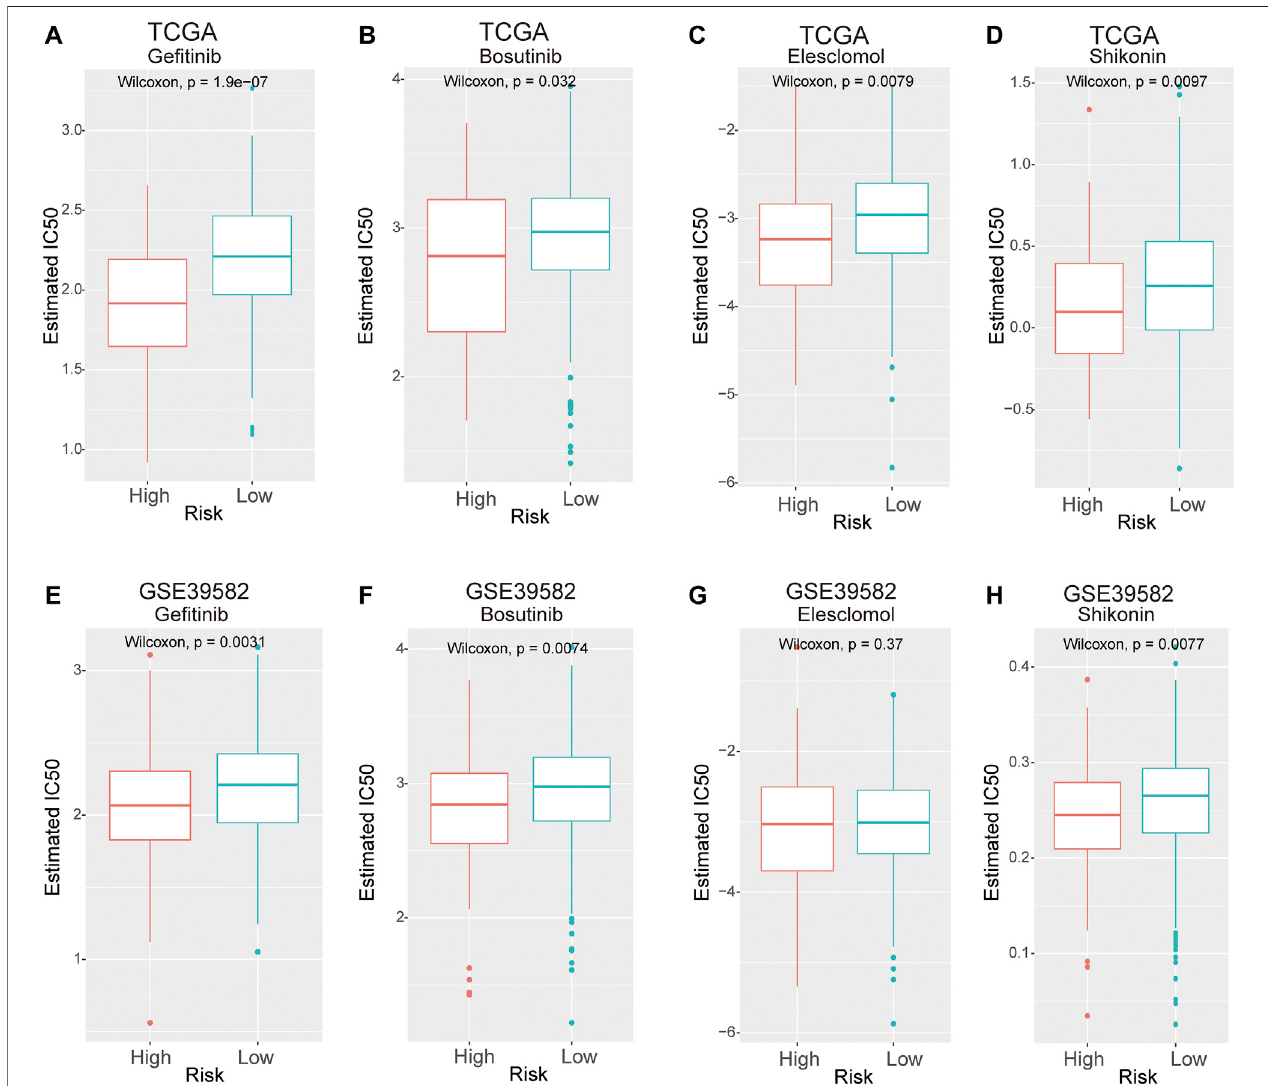
FIGURE8| TheIC50valuesoffourchemotherapeuticagentswithan8-lncRNAsignatureintheTCGAandGEOcohorts. (A – D) Ge fi tinib,camptothecin,bosutinib, and shikonin in the TCGA cohort. (E – H) Ge fi tinib, camptothecin, bosutinib, and shikonin in the GSE39582 cohort.